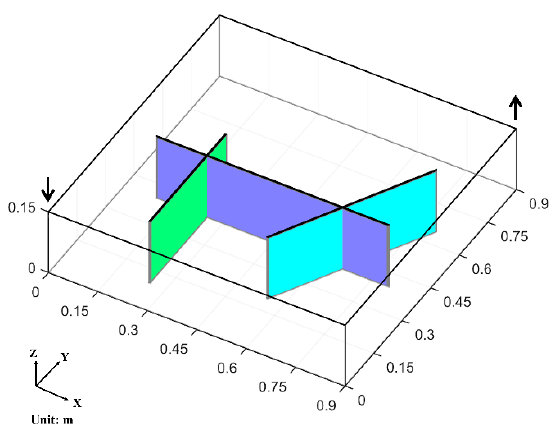
Figure 7. The fractured reservoir in Case 2. A water injector is placed in one corner of the reservoir and a producer is located in the opposite corner.